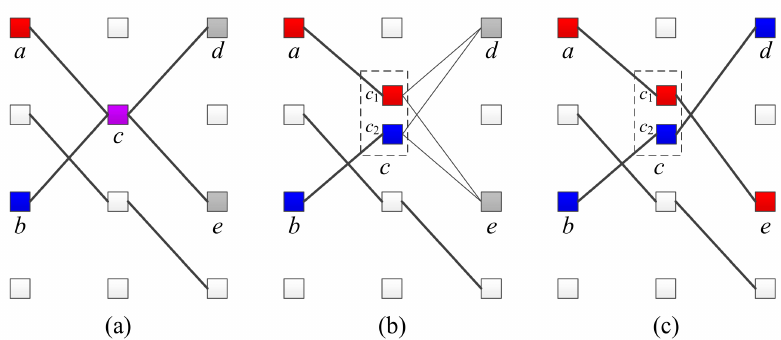
Figure 6. ( a ) Example of merger and separation occurrence of the tone-path; ( b ) Tone-space expansion with merged paths; ( c ) Performing message-passing and routing according to tone-space